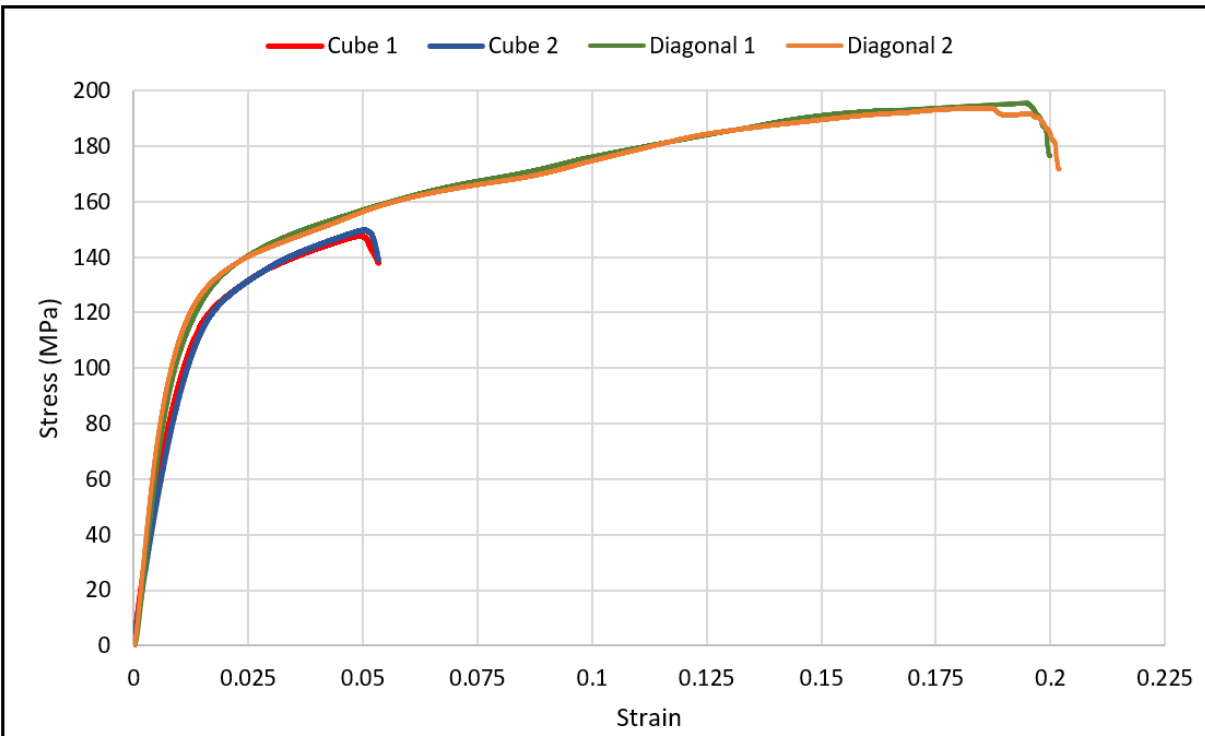
Figure 5. Flexural load-deflection curve for the cubic and scaffolds.